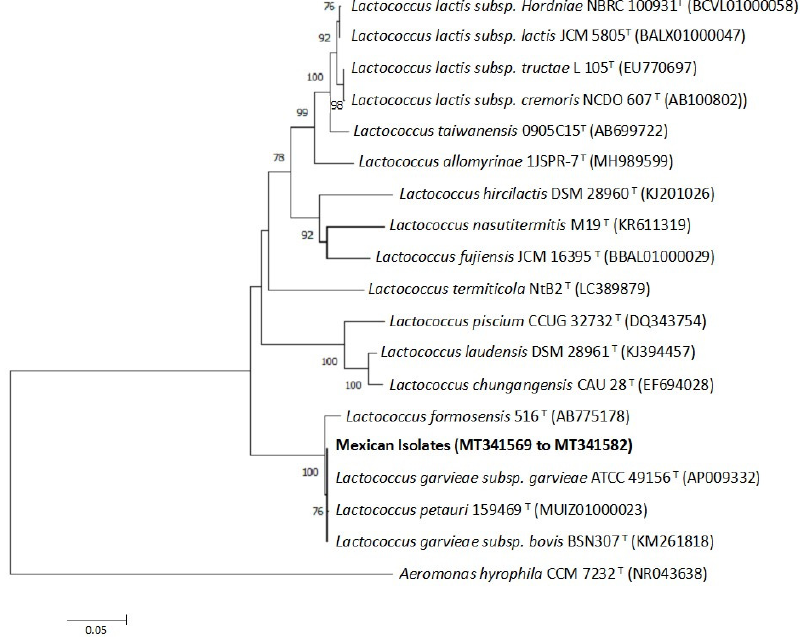
Figure 3. Inferred species relationships between the 14 Mexican isolates and other Lactococcus species, based on a neighbor-joining analysis of partial 16S rRNA gene sequences (1401 bp). Numbers at the nodes are bootstrap values (% of 10,000 replications; only values > 70% are shown). Bars indicate 0.05 substitutions per nucleotide.